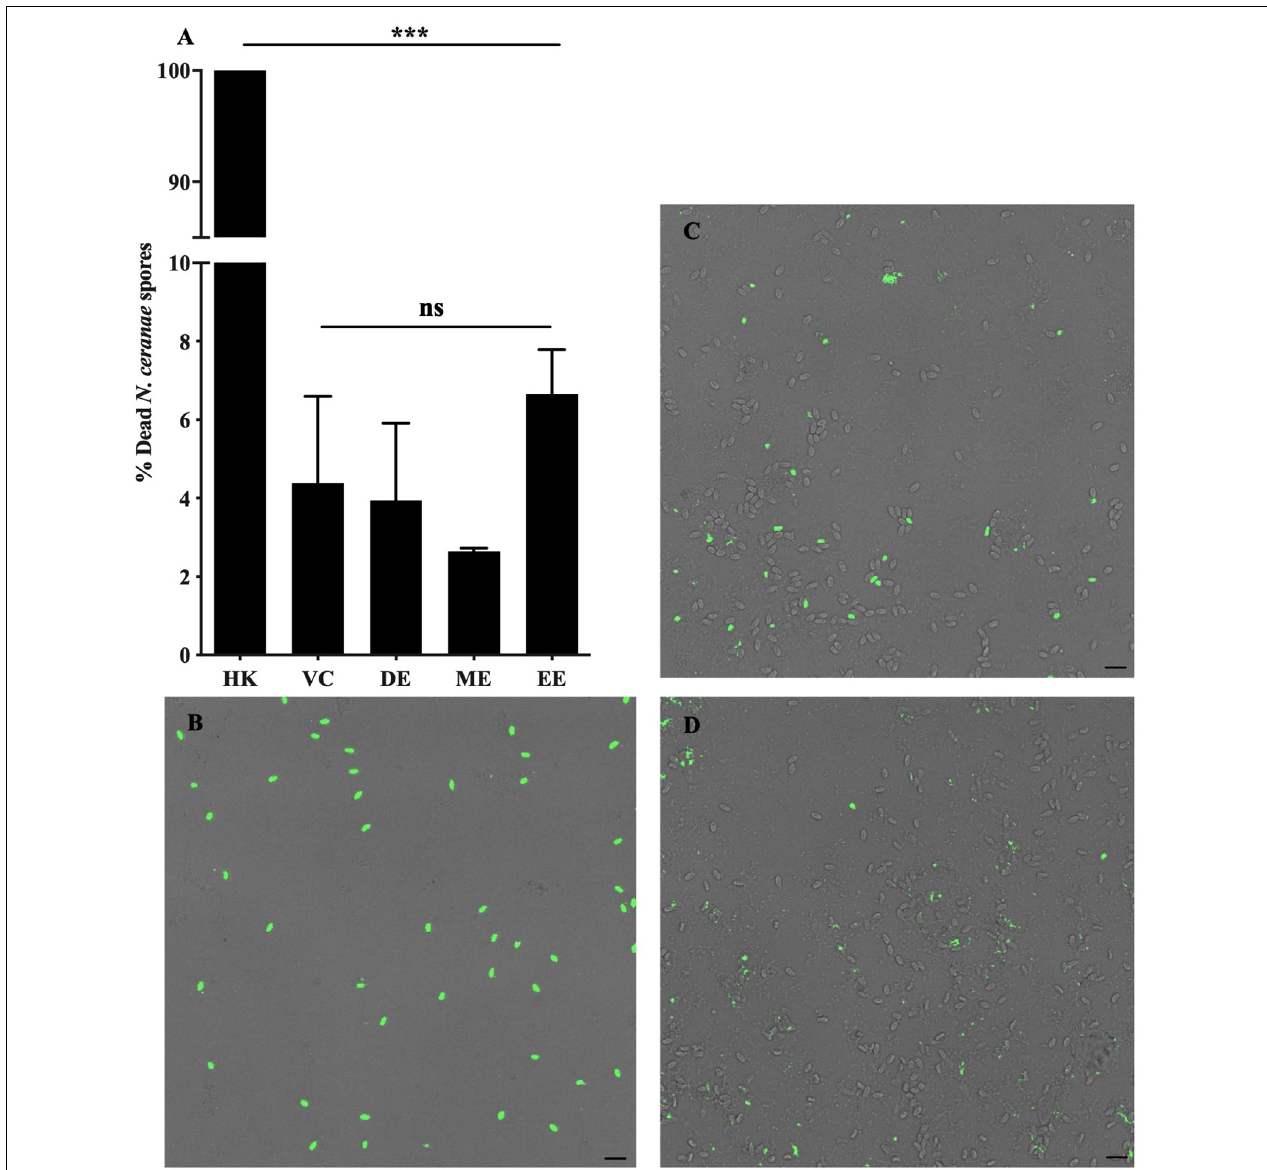
FIGURE 3 | Nosema ceranae spore viability following treatment with UNYP extracts in vitro . (A) Purified living spores were treated with dichloromethane extract (2.6 g/l, DE), methanol/water extract (2.6 g/l, ME), ethanol extract (2.6 g/l, EE), or a 7% ethanol vehicle control (VC) in 5% a sucrose solution for 24 h. Heat-killed spores (HK) served as a cell death control. Spores were fluorescently labeled with a nuclear cell viability dye following treatment and visualized with confocal fluorescent microscopy. Each value represents the mean ± SEM ( n = 3, ***indicates p ≤ 0.001). Representative fluorescent and bright field overlaid images of (B) heat killed spores (HK), (C) spores treated with VC, and (D) spores treated with DE are shown. Scale bar = 10 µ